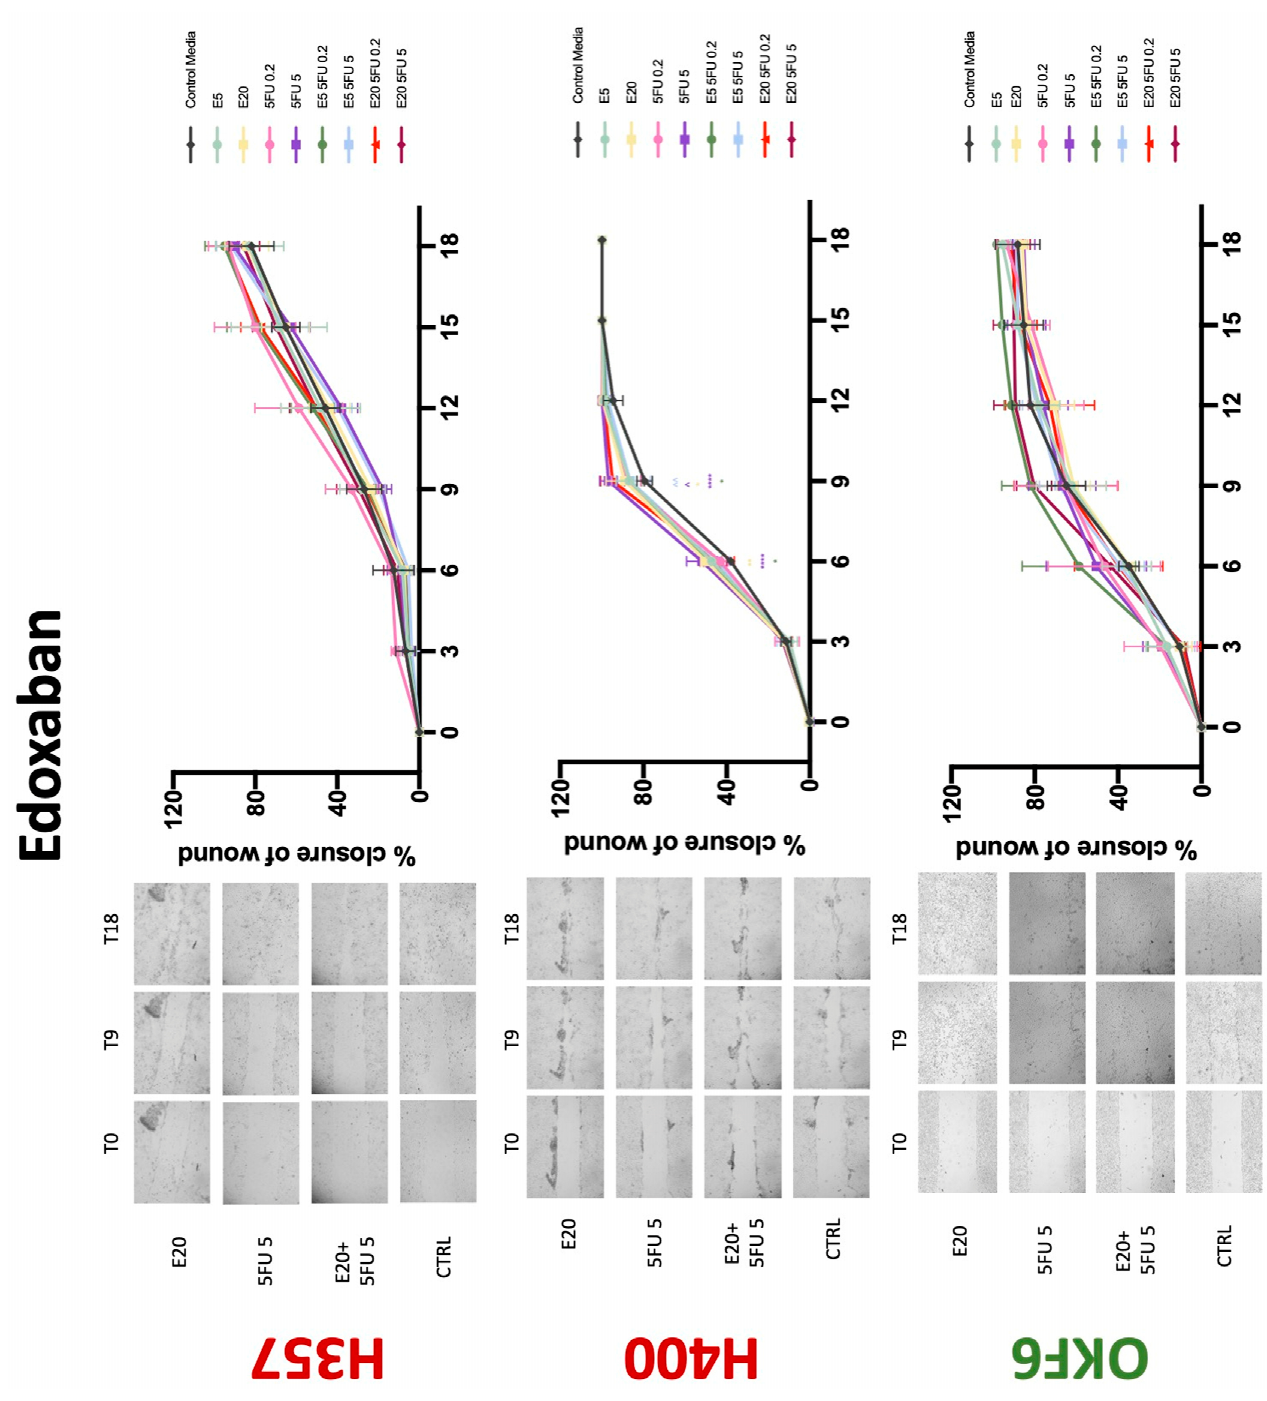
Figure 11. Wound healing assay . The effect of (5/20 µ M) edoxaban and (0.2/5 µ g/mL) 5-FU on H357, H400, and OKF6 cell migration. Data are represented as mean ± SD. Statistical significance is given as follows: * p < 0.05, ** p < 0.01, **** p < 0.001; (*) compared to control group; ^^ p < 0.01; (^) compared to respective 5-FU groups.